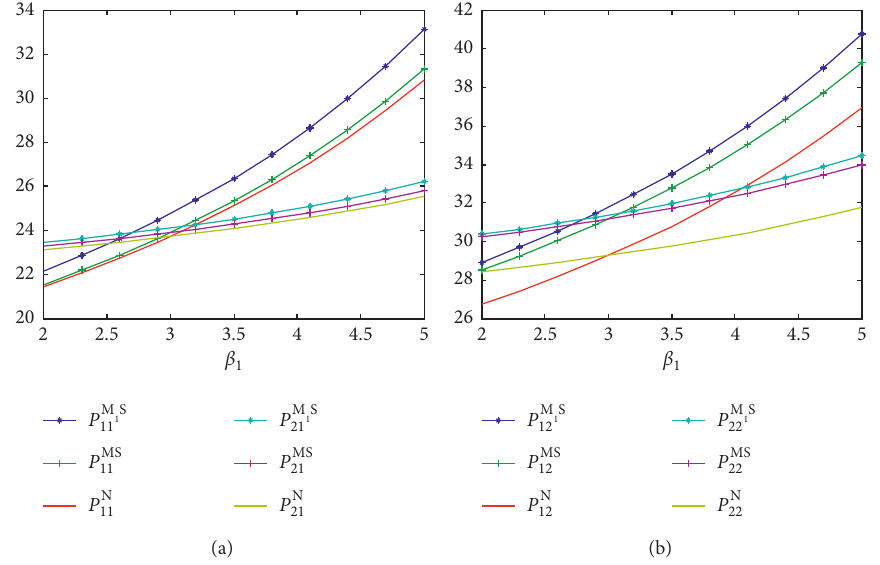
Figure 3: The effect of β on the optimal prices in the three models: (a) direct price; (b) retail price. 1